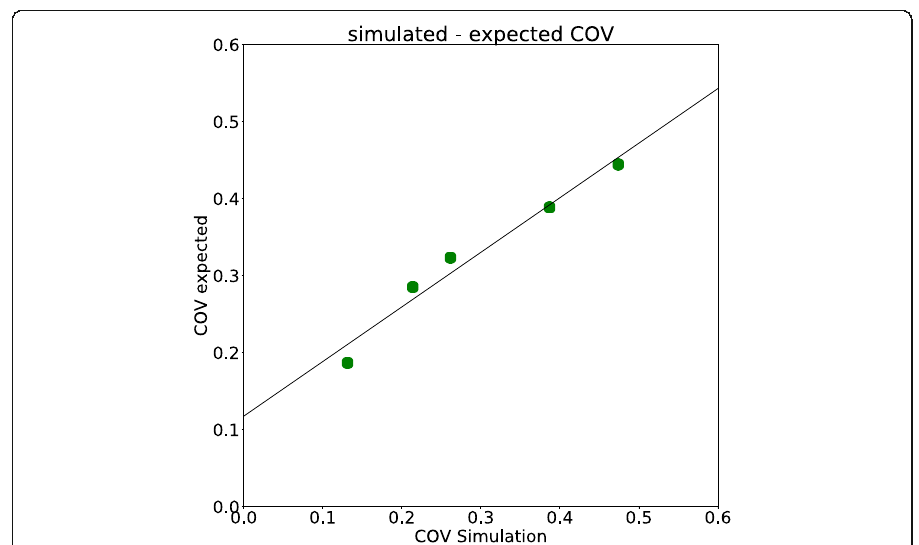
Fig. 5 The linear relationship between the COV values of the simulated and the expected TOF values (calculated with formula 2)